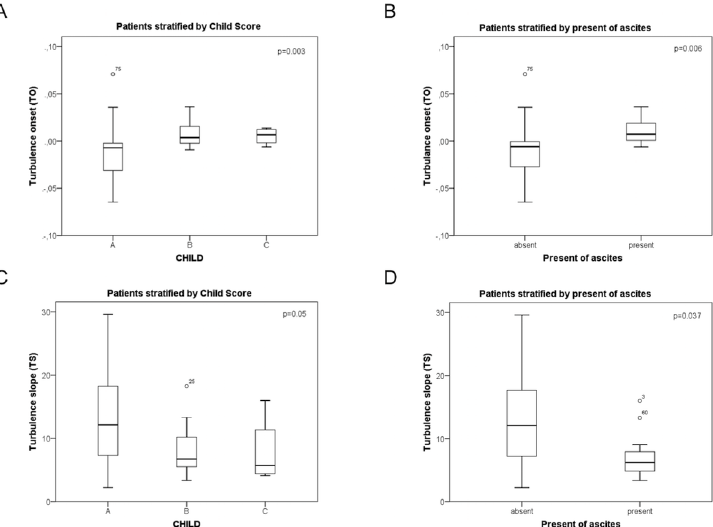
Fig 1. Turbulence onset and turbulence slope differ with respect to the Child score and complications of liver cirrhosis. Turbulence onset was stratified for Child score (A) and presence of ascites (B), as well as turbulence slope (C, D). Data were shown using boxplots and were analysed by Kruskal-Wallis test. Of note, data of two patients lay outside of the shown range, and were not shown to increase readability.